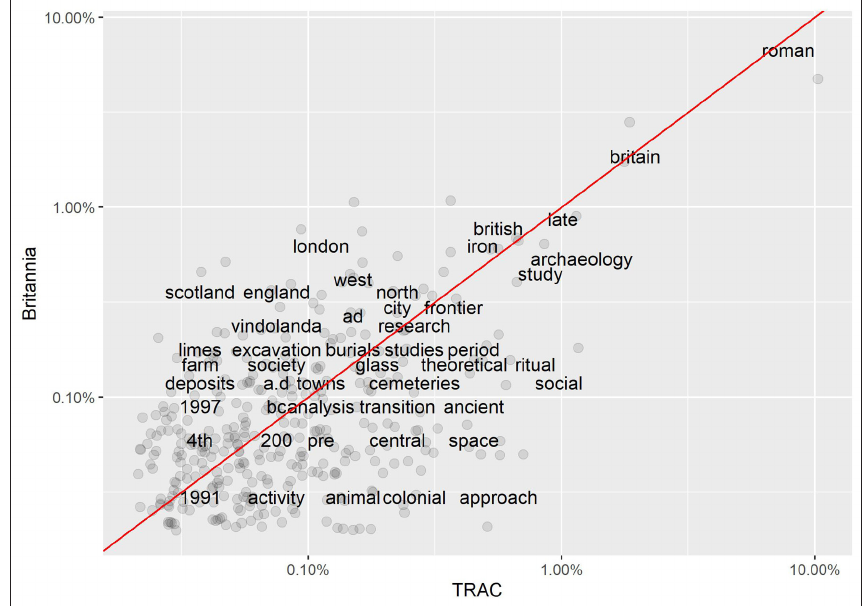
Figure 14: Frequency comparison plot of words used in article title – TRAC and Britannia (Note: words located above the red line are found more frequently in Britannia , compared to words located below that are more frequently found in TRAC